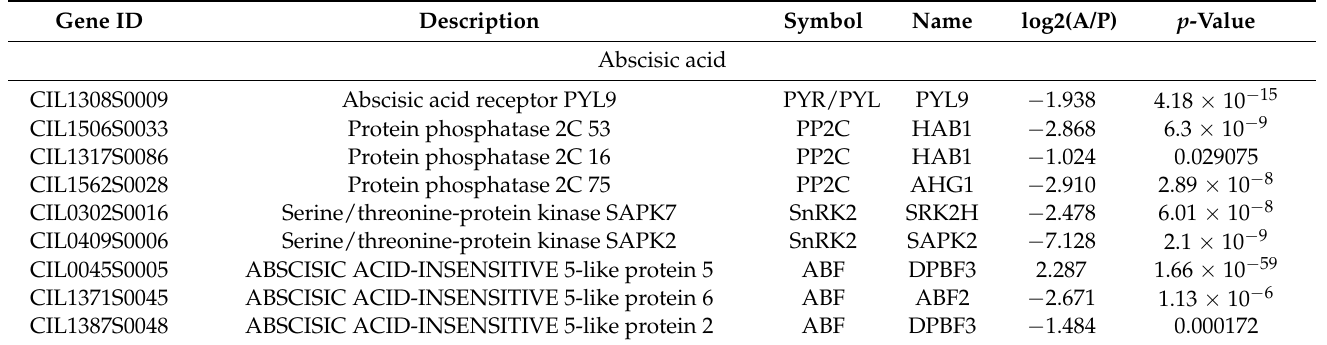
Table 3. Identified differentially expressed proteins involved in plant hormone signal transduction